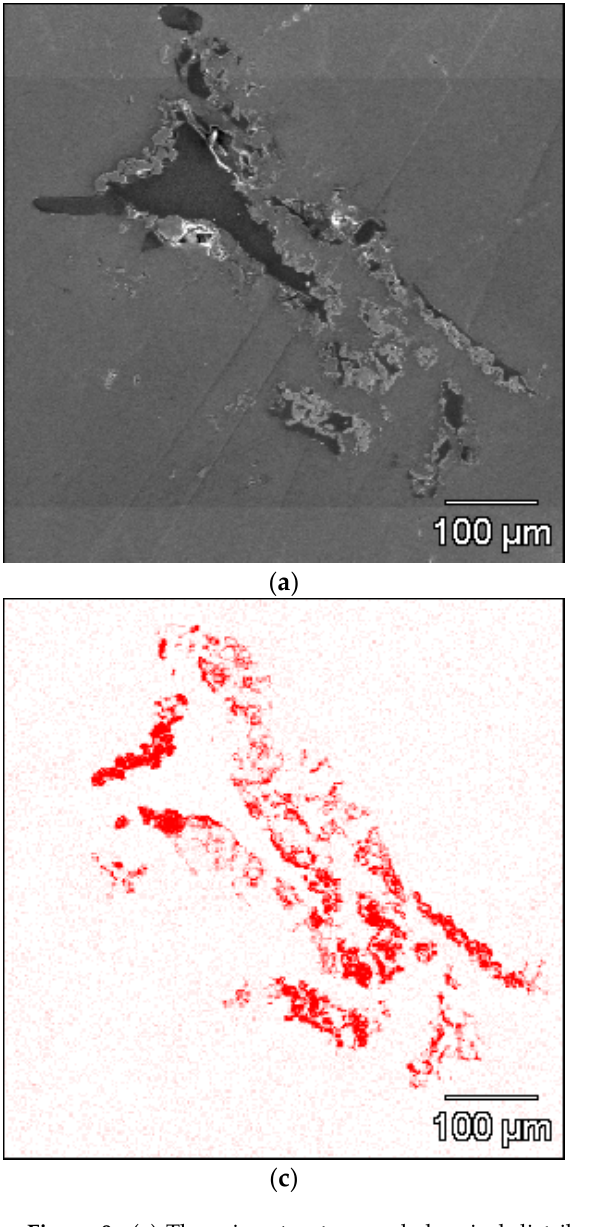
Figure 9. ( a ) The microstructure and chemical distribution of ( b ) aluminium; ( c ) titanium; ( d ) carbon compounds in composite with layers created by a suspension of 20 vol.% of Ti (SEM + EDS).